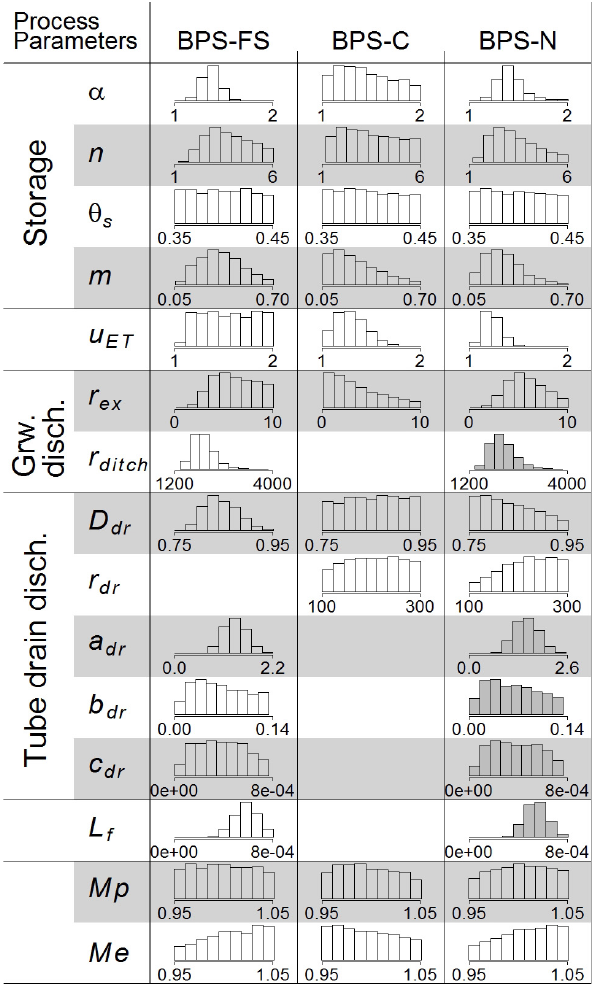
Fig. 9. Process-specific parameter distributions for the three behav- ioral parameter sets: BPS-FS, BPS-C, and BPS-N. The grey-filled distributions were only used for the field-site sub-model within the nested-scales model.